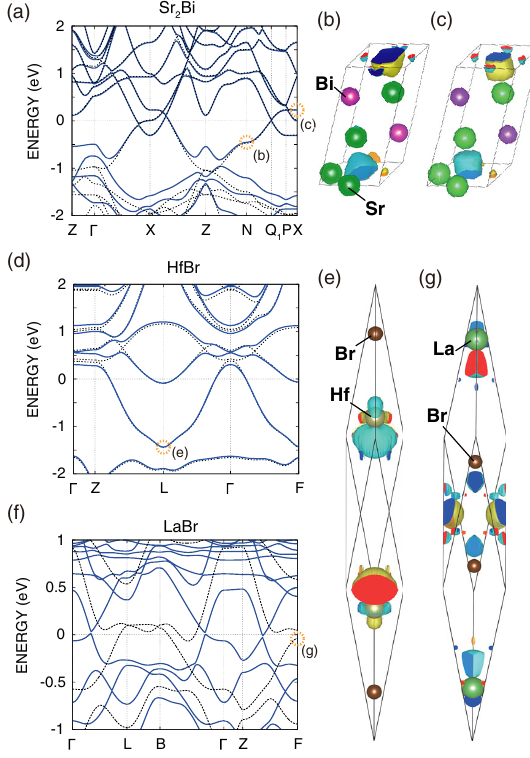
FIG. 5. Band structure of predicted topological electrides. (a) Electronic band structure of Sr 2 Bi in the GGA, where Z ¼ ð 0 ; 0 ; 1 Þ ; Γ ¼ð 0 ; 0 ; 0 Þ ; X ¼ ð 1 = 2 ; 1 = 2 ; 0 Þ ; N ¼ ð 1 = 2 ; 0 ; 1 = 2 Þ ; and P ¼ ð 1 = 2 ; 1 = 2 ; 1 = 2 Þ are high-symmetry points in the k space. The blue solid line and the black dotted line show the result without and with the SOI, respectively. (b),(c) Wave functions of the eigenstates originating from the interstitial electron at the N and X points in the calculation without the SOI. (d) Electronic band structure of HfBr in the GGA. The blue solid line and the black dotted line show the result without and with the SOI, respectively. (e) Wave function of the eigenstate originating from the interstitial electron at the X point in the calculation without the SOI. (f) Electronic band structure of LaBr in the GGA. The blue solid line and the black dotted line show the result without and with the SOI and magnetism, respectively. (g) Wave function of the eigenstate originating from the inter- stitial electron at the F point without the SOI. The results shown in (b) and (c), (e), and (g) correspond to the states indicated by the dotted circles in (a), (d), and (f), respectively. The Brillouin zones of HfBr and LaBr are the same as that of the Y 2